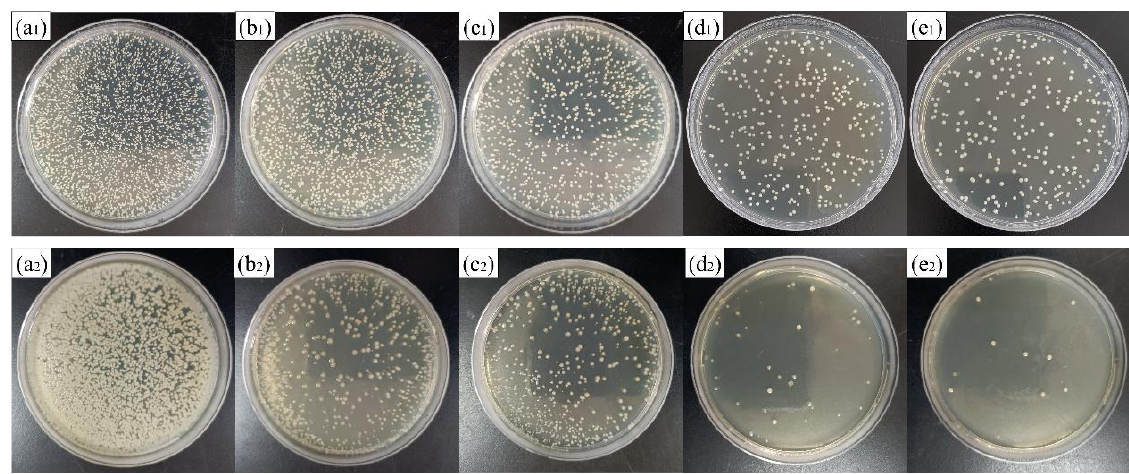
Figure 10. Typical photos of the re-cultivated S. aureus and E. coli colonies on agar for different samples, respectively: ( a 1 , a 2 ) Ti-substrate; ( b 1 , b 2 ) ZrN/Ag 2 O (1 × 10 16 ions/cm 2 ); ( c 1 , c 2 ) ZrN/Ag 2 O (5 × 10 16 ions/cm 2 ); ( d 1 , d 2 ) ZrN/Ag 2 O (10 × 10 16 ions/cm 2 ); and ( e 1 ,e 2 ) ZrN/Ag 2 O (15 × 10 16 ions/cm 2 ) gradient composite coatings.